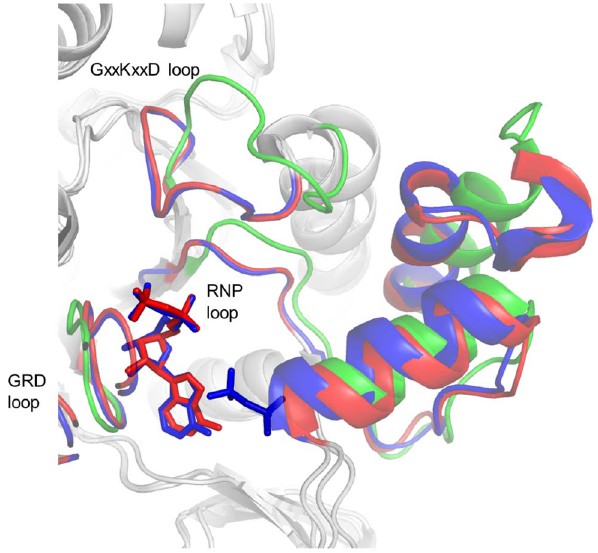
Figure 3. The substrate binding site. The structures of the ligand- free ATPS of A. vinosum (red), the ATPS-APS of P. chrysogenum (green) and the ATPS-APS-PP i of S. cerevisiae (blue) are superimposed thereby focusing on the pronounced loop segments that are subjected to a conformational change upon substrate binding. As a result, the substrate binding groove is shrunk from an open form characterized in the A. vinosum and ‘‘ Candidatus E. persephone’’ ATPS structures to a more closed form found in the structures of S. cerevisiae, P. chrysogenum, Aquifex aeolicus and T. thermophilus ATPS in complex with the substrates (or substrate analogues).